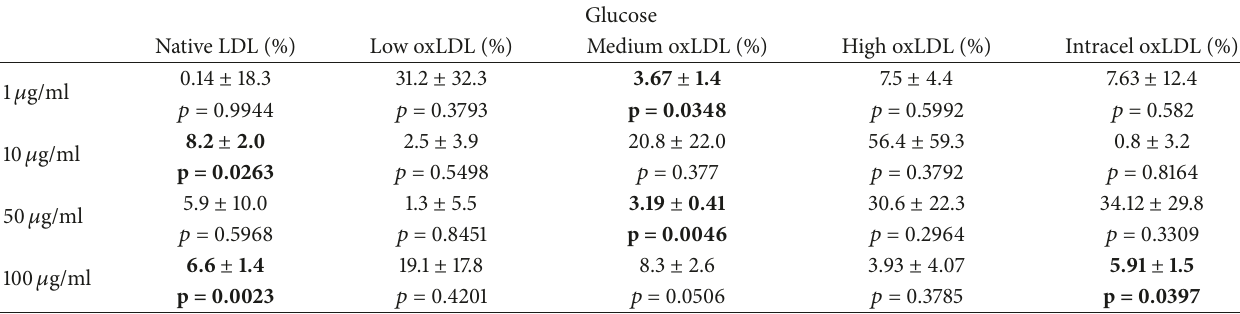
Table 1: Metabolic glucose consumption of various LDL exposure to macrophages. Mean peak MAMP height changes and standard errors for each experimental condition during exposure. All 𝑝 values are calculated based on peak height versus 10min average basal value prior to exposure. Terms in bold are representative of 𝑝 < 0.05 , indicating statistical significance.